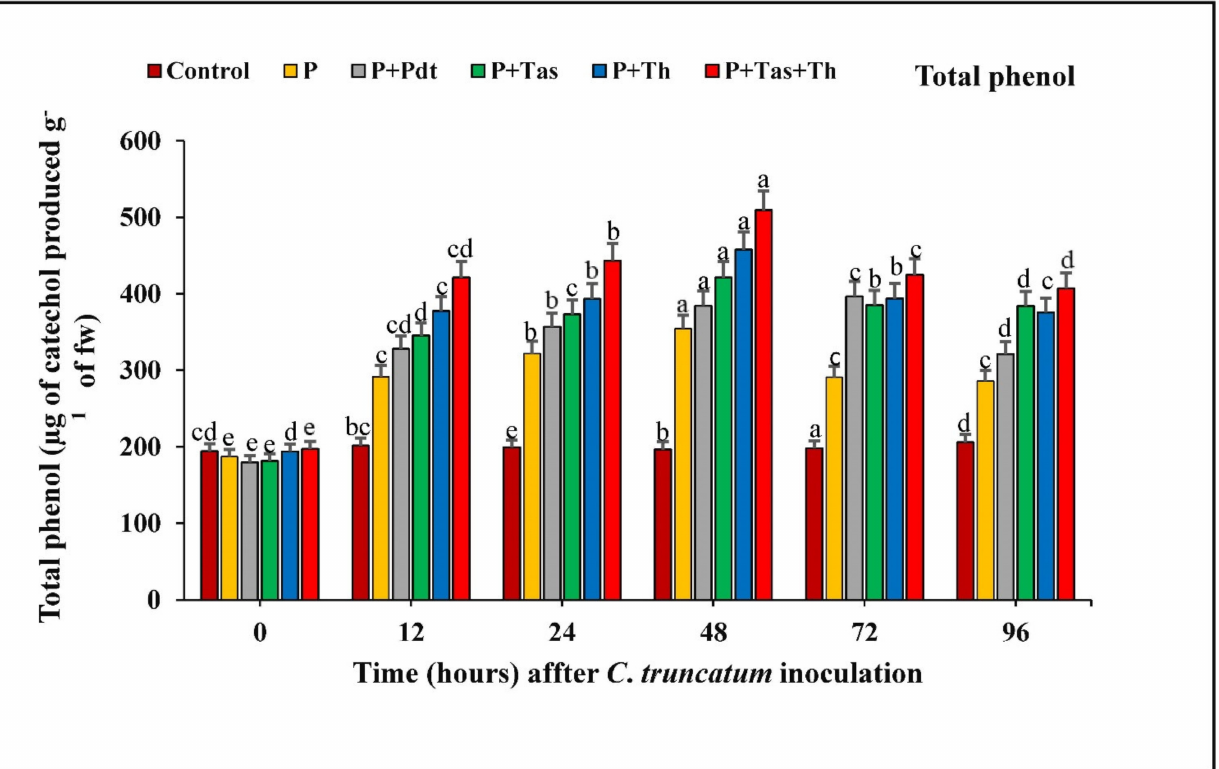
Figure 14. The effect of bioagents (Pdt = P. dendritiformis, Tas = T. asperellum, Th = T. harzianum, and Tas+Th = T. asperellum + T. harzianum ) on the production of total phenols either individually or in the combination of treatment in chilli seeds under a challenged condition and C. truncatum -infected samples. Each value is expressed as the mean of triplicates, and the bars sharing the same alphabetical letters are not significantly different ( p ≤ 0.05) using Duncan’s multiple range test. The vertical bar designates the standard